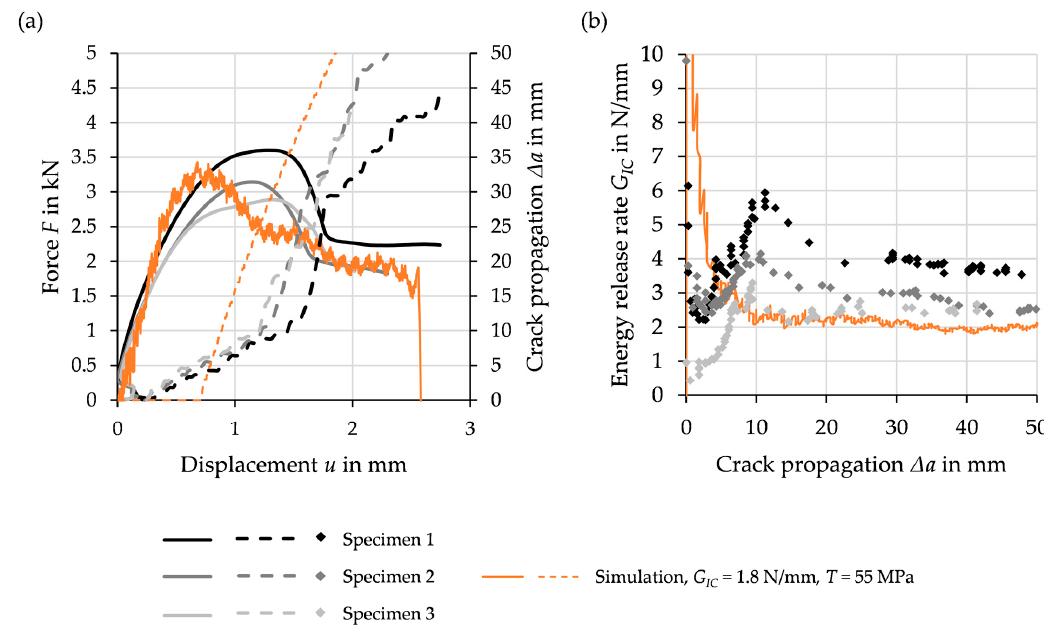
Figure 14. Comparison of the ( a ) force-displacement-curves and ( b ) crack propagation-displacement-curves, between experiment and simulation.